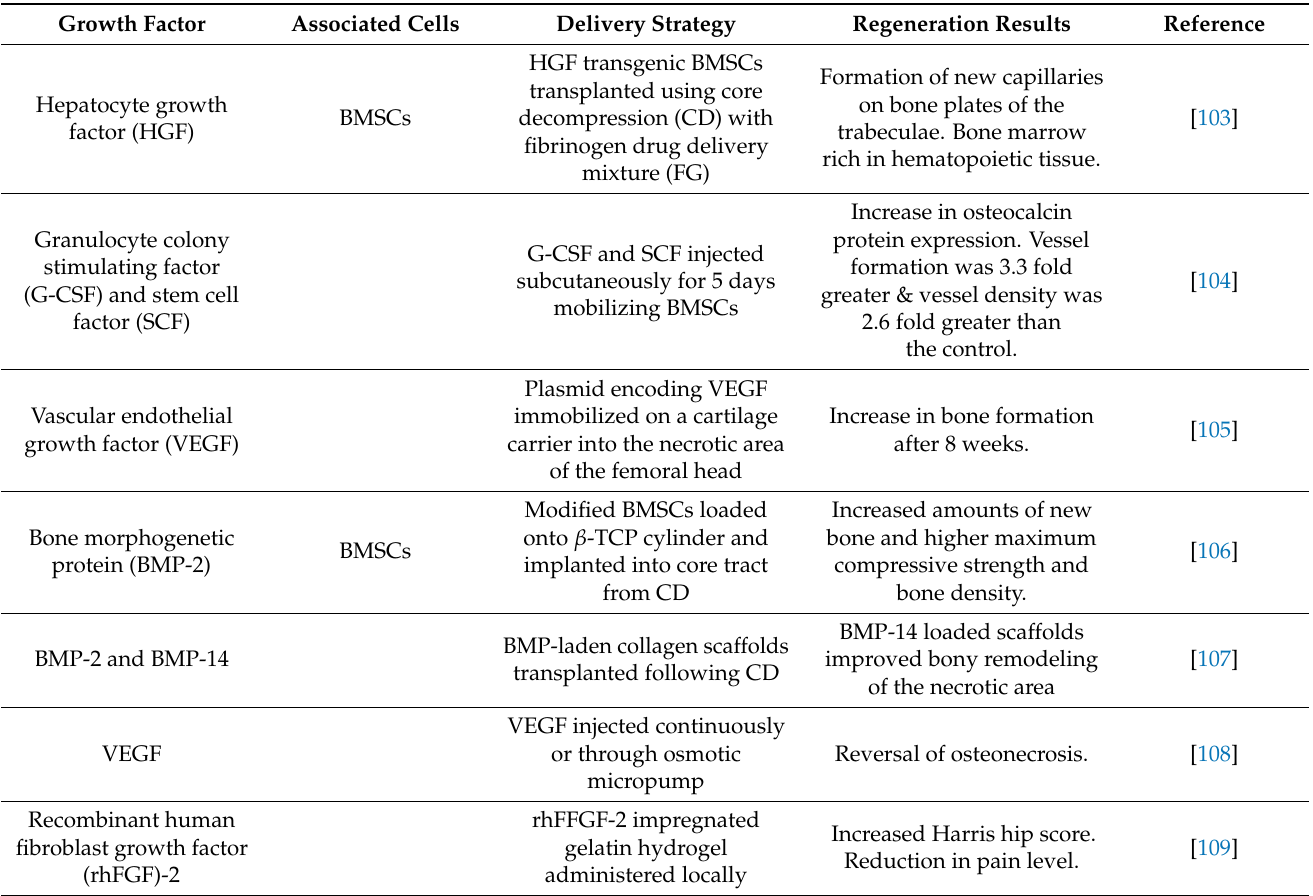
Table 1. Use of growth factors for the regeneration of the bone and vasculature of the necrotic femoral heads have been practiced clinically. They can be injected or delivered through overexpression by genetically transfected stem cells. Growth Factor Associated Cells Delivery Strategy Regeneration